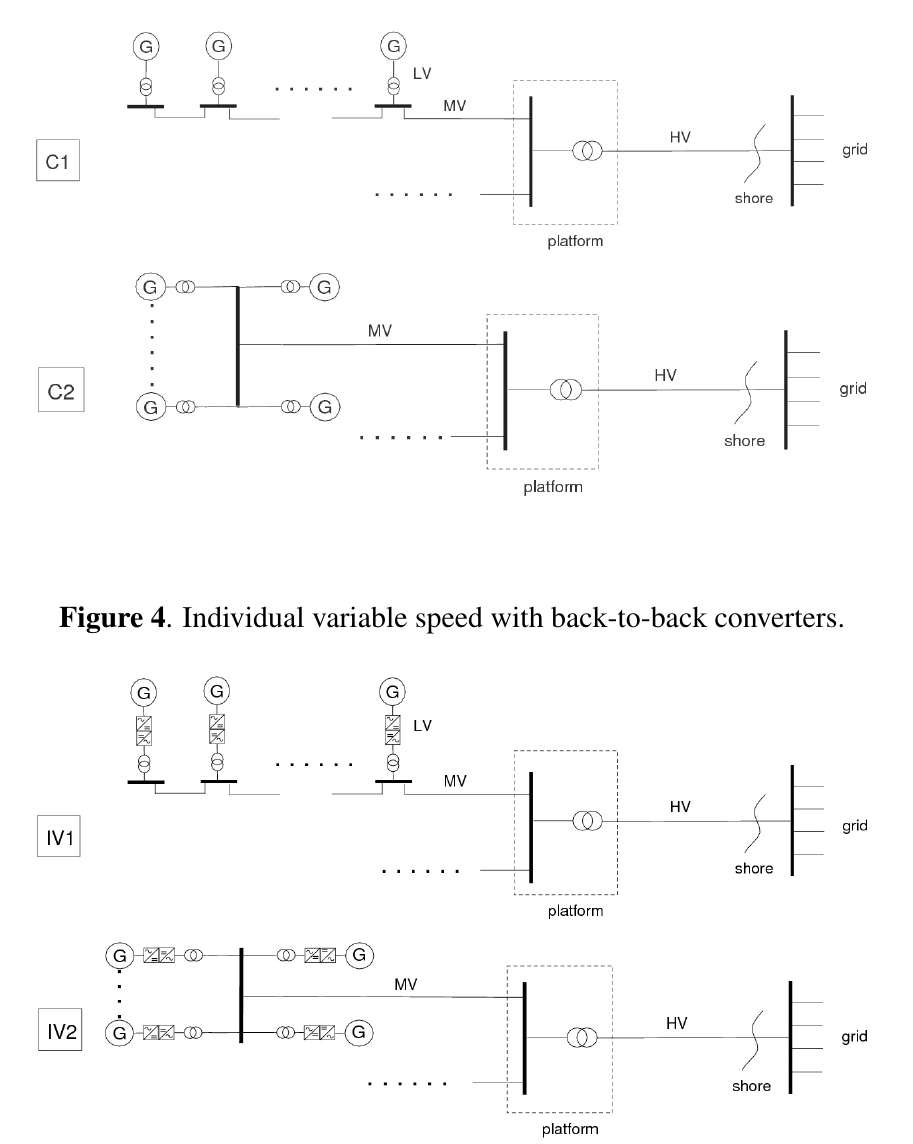
Figure 3 . Constant speed systems.